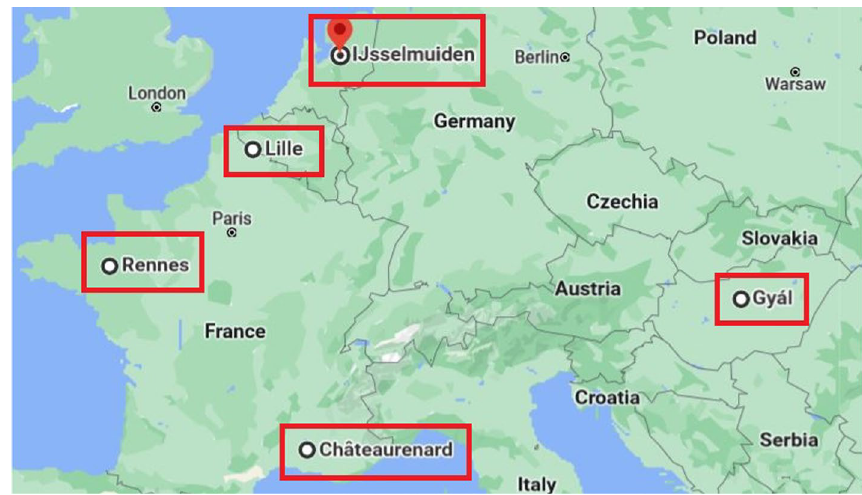
Fig. 3 Five destinations in Europe. Source : authors’